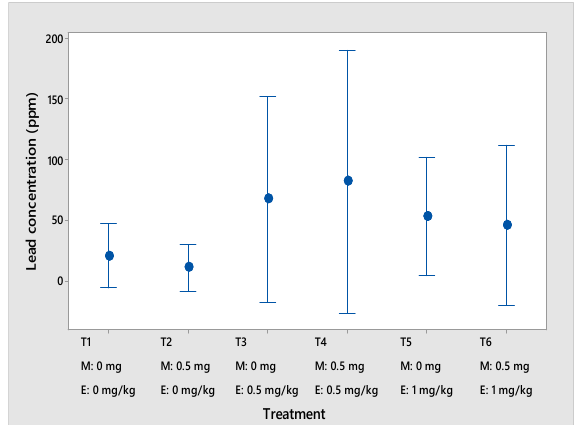
Figure 4. Lead concentrations in the aerial parts of the treated plants